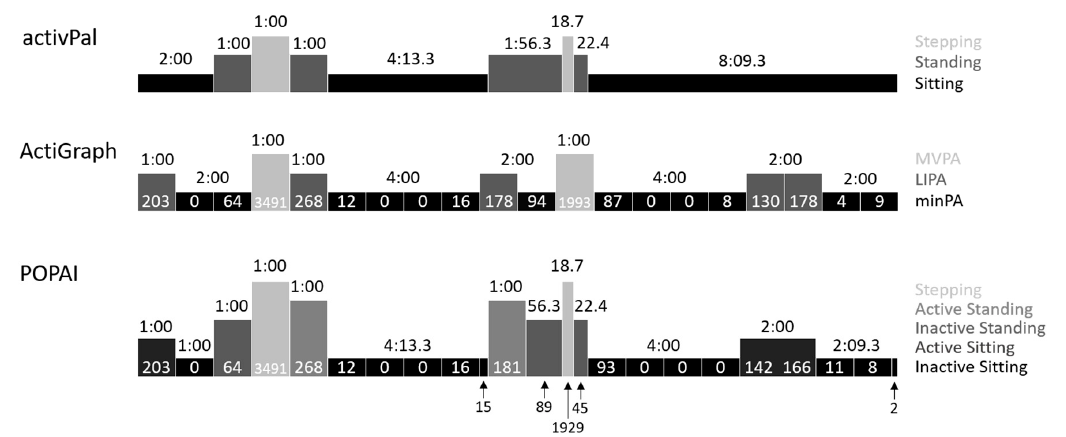
Figure 2. Exemplary classification of a 20-min recording with each method. Indicated is the behavior duration (in minutes:seconds) and the ActiGraph counts. Abbreviations: minimal-intensity physical activity (minPA), light-intensity physical activity (LIPA), moderate- to vigorous-intensity physical activity (MVPA), Posture and Physical Activity Index (POPAI).